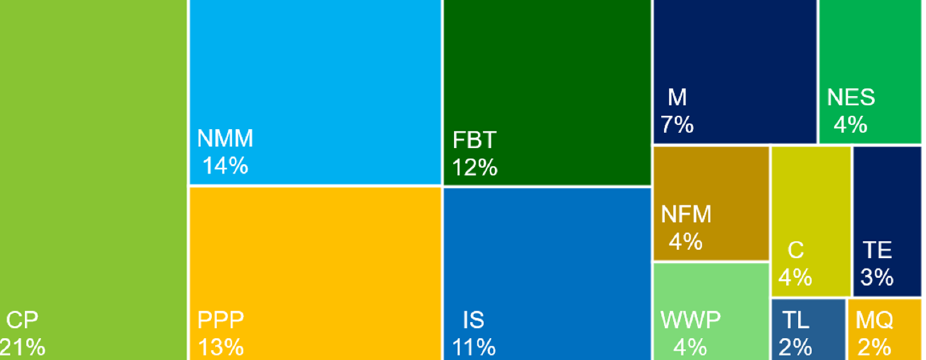
Figure 1. EU Energy consumption share of industrial sectors. Based on data from [24]. (CP, Chemical and Petrochemical; NMM, Non-Metallic Minerals; PPP, Paper, Pulp, and Printing; FBT, Food, Bev- erages, and Tobacco; IS, Iron and Steel; M, Machinery; NES, Not Elsewhere Specified; NFM, Non- Ferrous Metals; WWP, Wood and Wood Products; C, Construction; TE, Transport Equipment; TL, Textile and Leather; MQ, Mining and Quarrying).